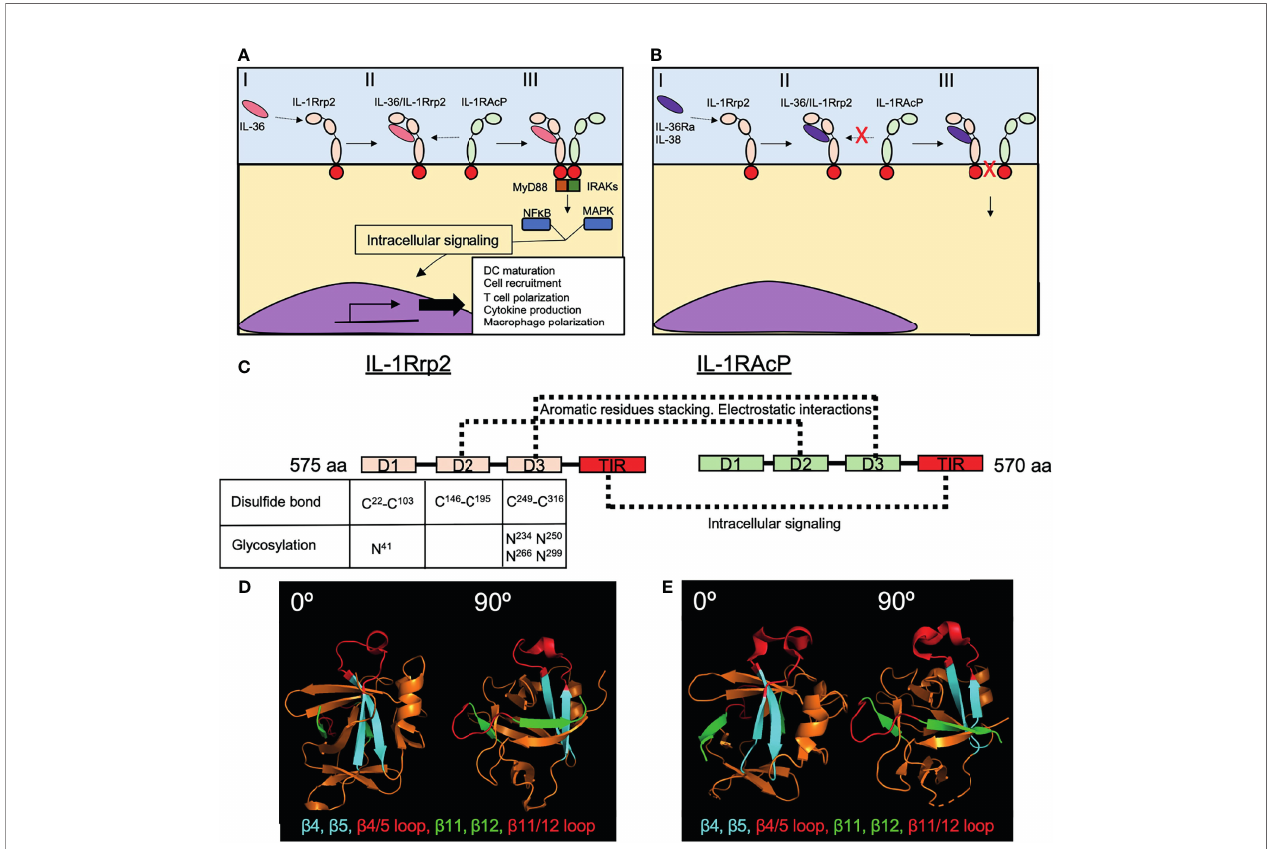
FIGURE 4 | Recognition of IL-36 cytokines by the IL-1Rrp2/IL-1RAcP complex. (A) The initial recognition of IL-36 agonists by IL-1Rrp2 on the surface of the cell (I), triggers the recruitment of IL-1RAcP to the receptor-ligand complex (II), initiating an intracellular pathway characterized by the activation of MyD88 and IRAKs and then NF k B and MAPK that will induce the transcription of several genes involved in DC maturation, T cell and macrophage polarization and cytokine production (III). (B) IL-36Ra and IL-38 also bind IL-1Rrp2 (I) but this binding does not recruit IL-1RAcP (II), thus inhibiting the in fl ammatory response triggered by IL-36 agonists (III). (C) IL-1Rrp2 and IL-1RAcP are composed of three extracellular domains (D1-D3) and one TIR intracellular domain. Disul fi de bonds and N glycosylation found in D1, D2 and D3 of IL-1Rrp2 are critical for IL-1Rrp2/IL-36 binding. Direct interactions between IL-1Rrp2 and IL-1RAcP through their respective D2s and D3s have been identi fi ed in absence of IL-36 agonists. (D) Loops between b 4/ b 5 and b 11/ b 12 present in human IL-36 g (PDB 4IZE) mediate interaction with IL-1RAcP. (E) Mouse IL-36Ra (PBD 4P0L) has similar loops in these regions with a slightly different structural conformation that avoid the interaction with IL-1RAcP. Crystal structures were obtained from the Protein Data Bank (https://www.rcsb.org) and modeled in PyMOL